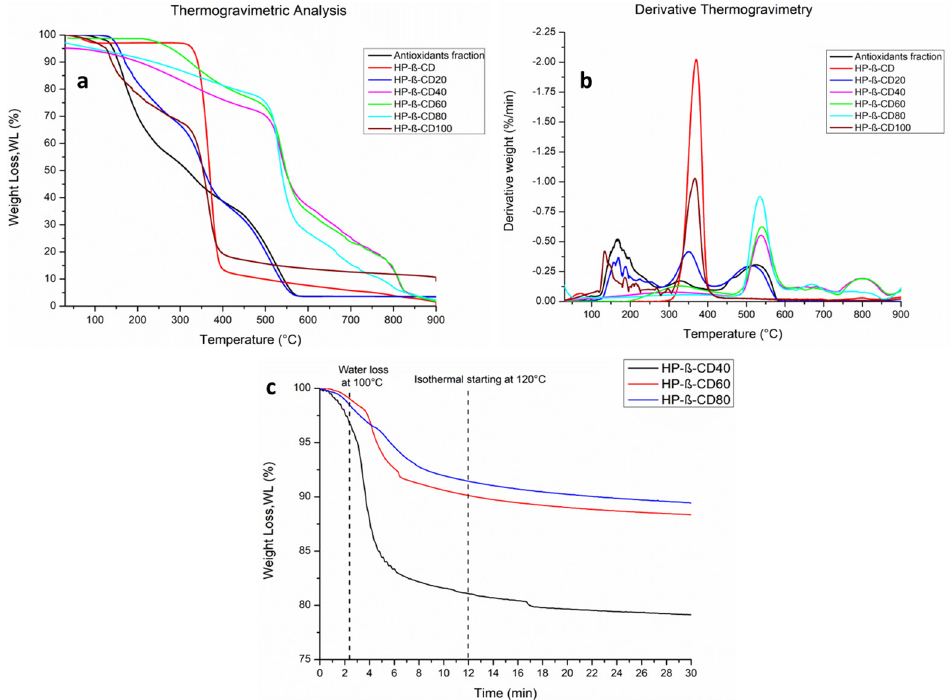
Figure 3. TGA, ( a ), and DTG, ( b ), of all samples; isothermal thermogravimetric analysis of HP- β - CD40, 60 and 80 ( c ).